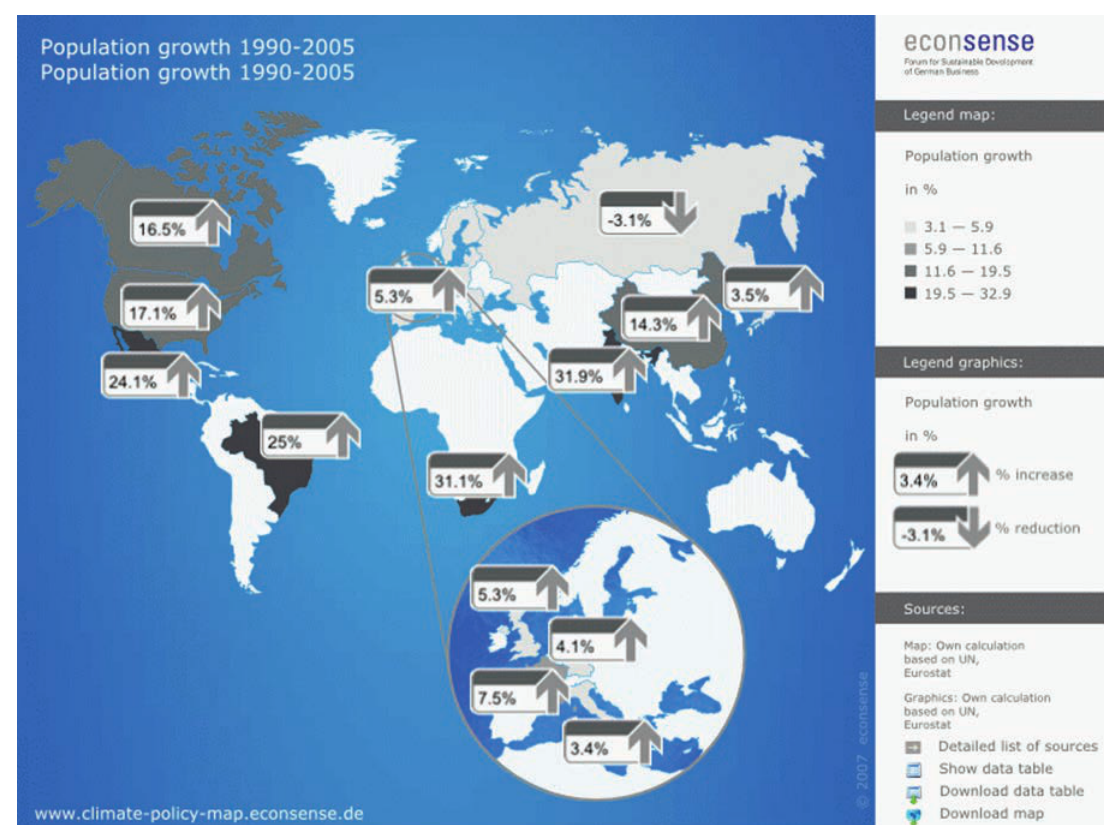
Fig. 2 Worldwide population growth by regions in %.